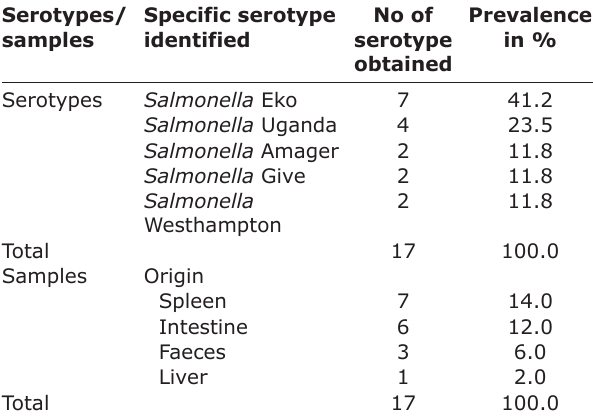
Table-1: Serotype-sample prevalence of Salmonella isolated from camel in Maiduguri, sub-Sahara